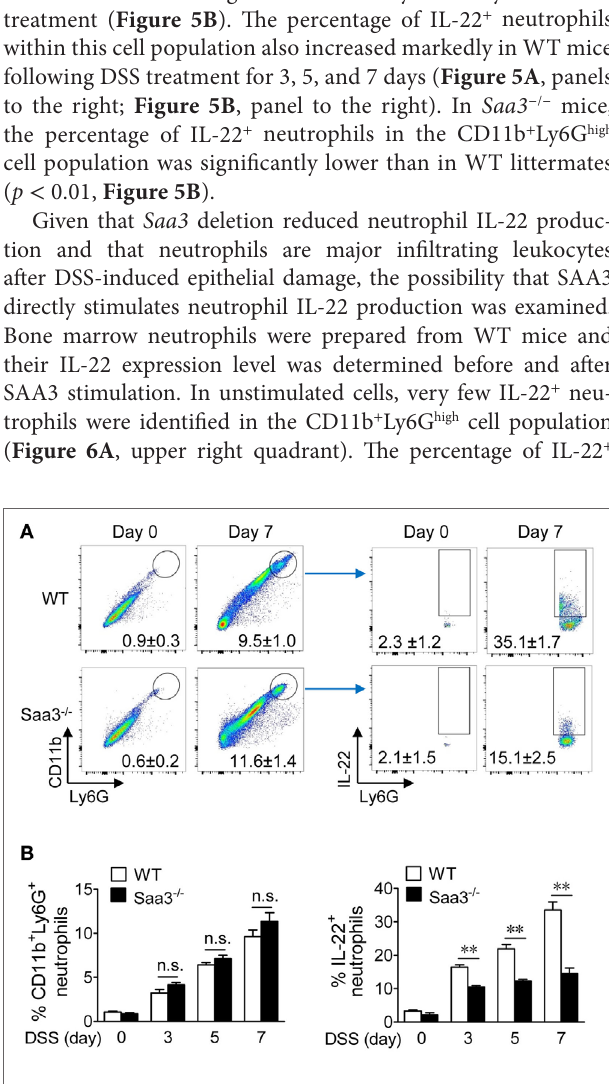
FigUre 5 | Flow cytometry analysis of colonic neutrophils in wild type (WT) and Saa3 − / − mice. Male and female mice 8–10 weeks of age were used in the experiments. (a) Representative flow cytometry dot plots of colonic neutrophils from WT and Saa3 − / − mice were determined (left panels). This population of neutrophils was further analyzed by IL-22 staining (right), based on data from five mice in each group treated with dextran sulfate sodium (DSS) for 0, 3, 5, and 7 days. Data collected on day 7 were shown. The quantification results are shown in (B) for the percentage of CD11b + Ly6G high cells (left) and the percentage of IL-22 + neutrophils in that population of neutrophils (right). Shown are mean ± standard margin of error based on three measurements. ** p < 0.01 between samples.